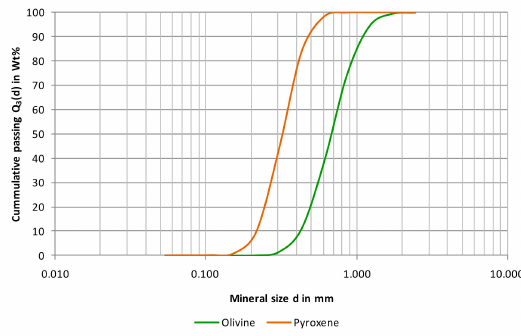
Figure 14. Mineral grain size distribution of phenocrysts (olivine and pyroxene). Grain